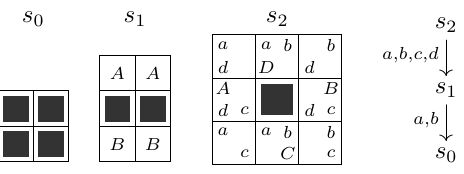
2 , 1) -achieving P 4 , 4 (cid:1)